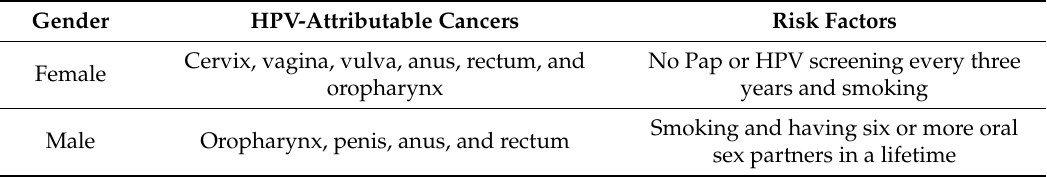
Table 4. Types of HPV-attributable cancer and factors that elevate the risk of dying from them. Gender HPV-Attributable Cancers Risk Factors Cervix, vagina, vulva, anus, rectum, and No Pap or HPV screening every three Female oropharynx years and smoking Smoking and having six or more oral Male Oropharynx, penis, anus, and rectum sex partners in a